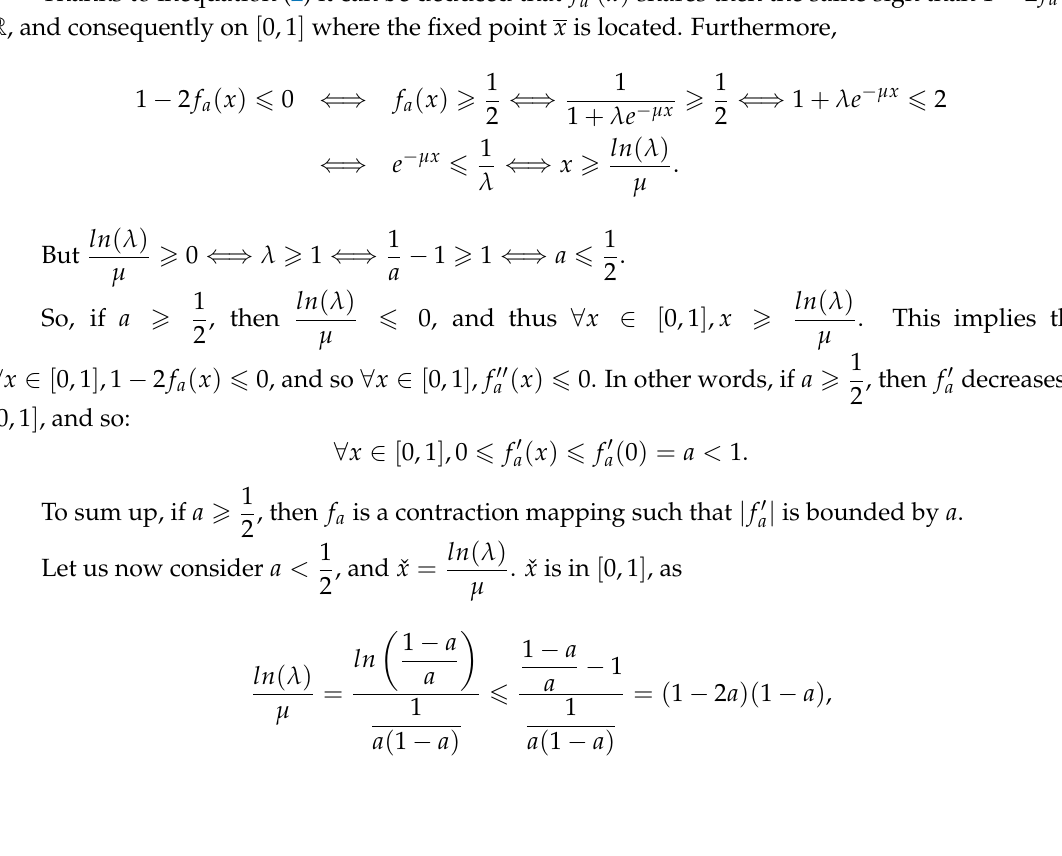
Figure 8. Graph of numerical solution of equation x =